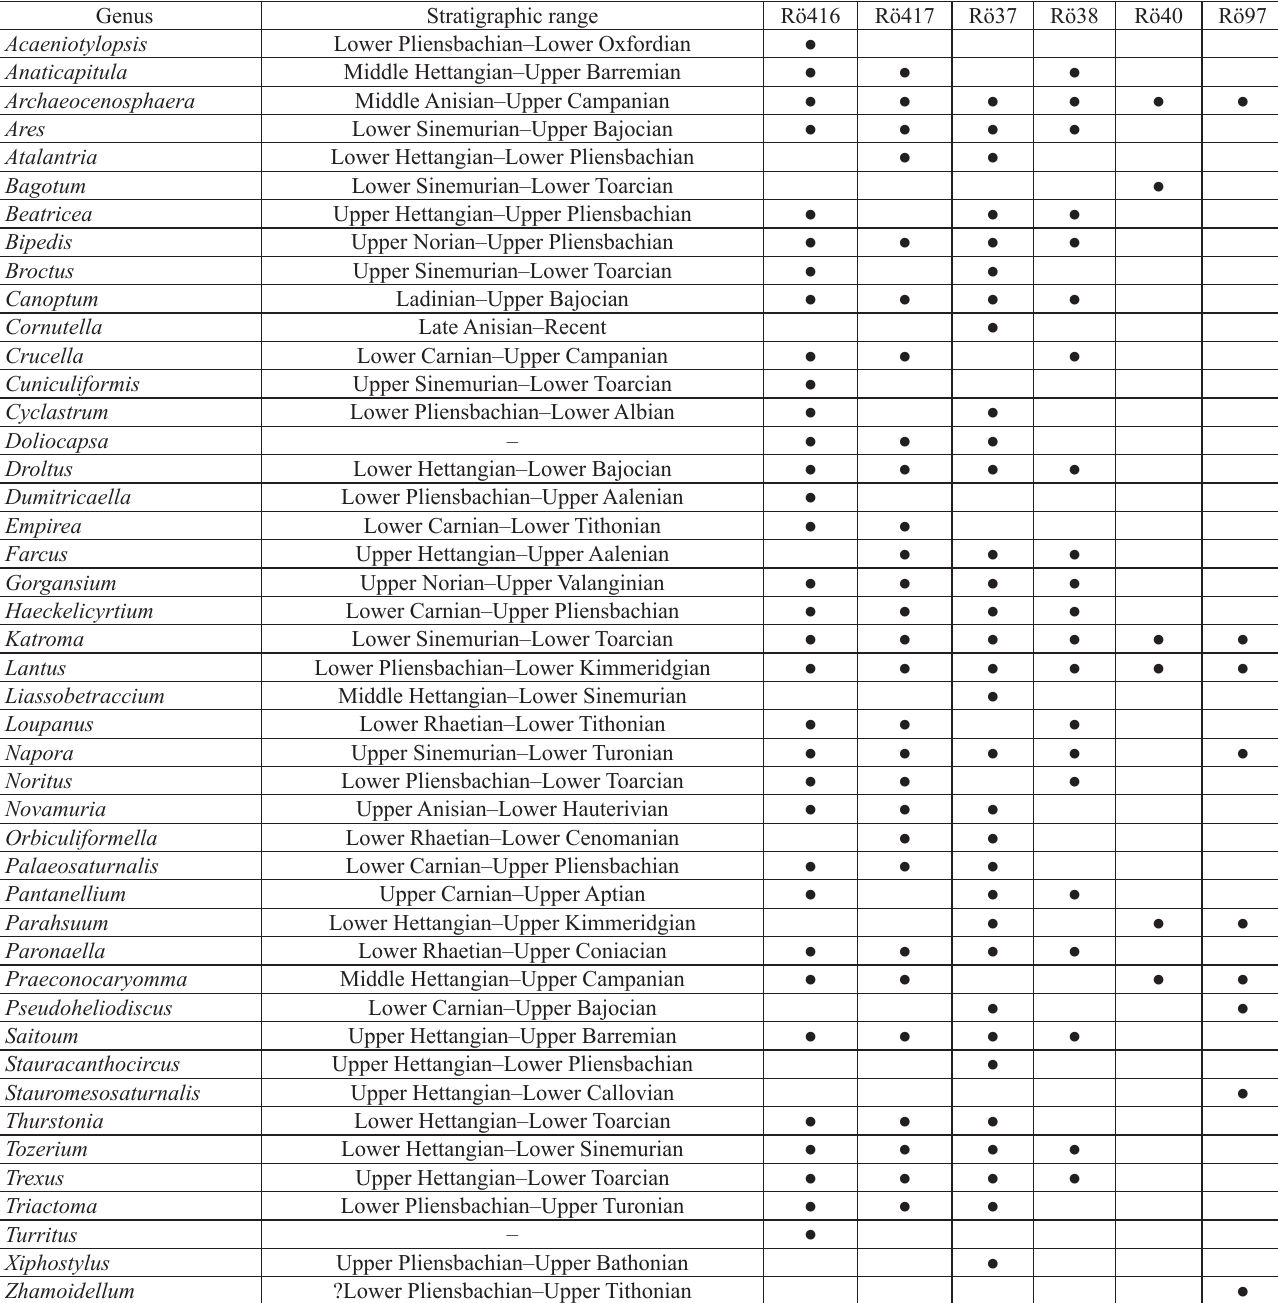
Table 5. Occurrence of genera in the samples studied. Stratigraphic ranges based on O’Dogherty et al. 2009; genera with blank ranges were described after 2009. Sample age: Rö417, Rö37, Early Pliensbachian; Rö416, Rö38, Pliensbachian; Rö40, Rö97, Early Pliensbachian–Early